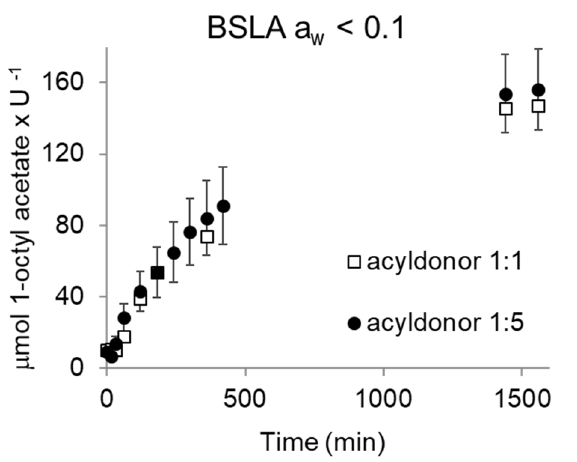
Figure 6. Activity of BSLA, toluene at a w < 0.1. Reaction conditions: 0.5–1.2 U of catalyst, 100 mM 1-octanol, 100 mM or 500 mM vinyl acetate, 500 mM decane (ISTD), in dry toluene (1 mL reaction) at 30 °C and 1000 rpm. U: µmol butyric acid x min -1 . Blanks were performed in the absence of enzyme and showed no conversion.